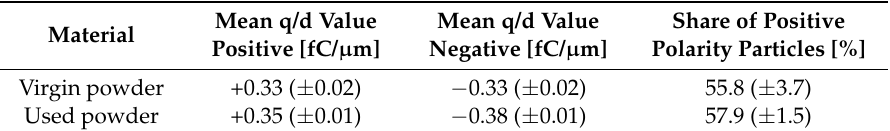
Table 2. Mean q/d values for positive and negative charged particles and share of positive polarity particles obtained by q/d-meter measurement of virgin and aged PA12. Values in brackets represent the standard deviation over three measurements.